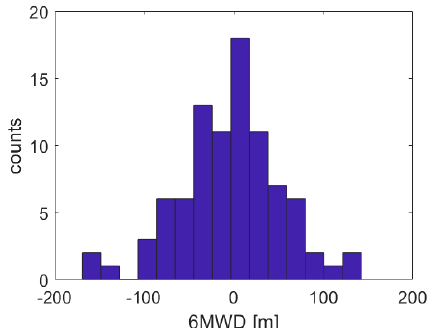
Figure 3. Error distribution in 6MWD prediction. Mean average error is equal to 42.5 m (±35.5 m).